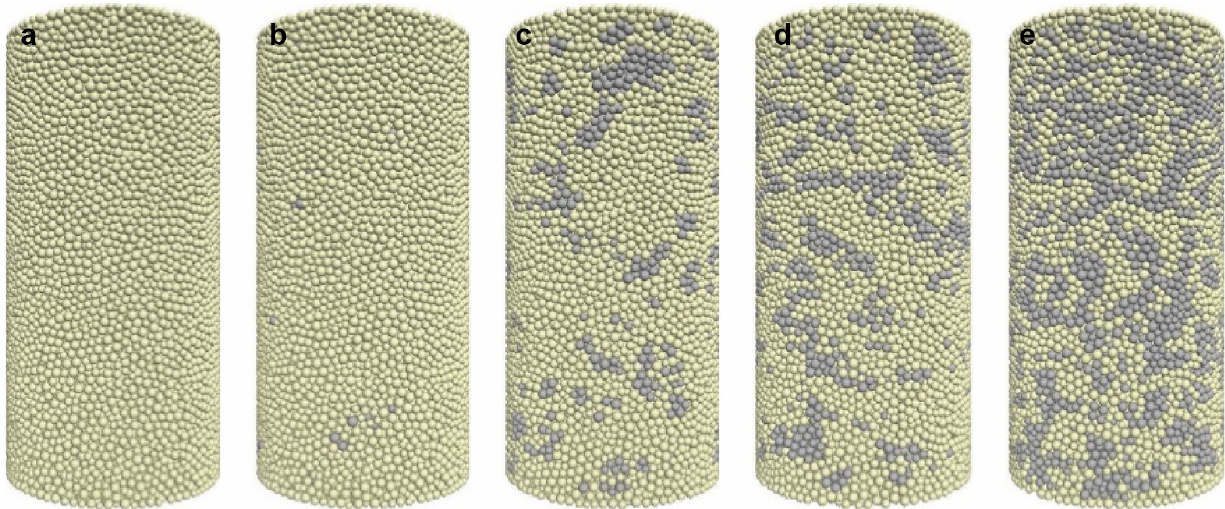
Fig. 12 Initial PFC models (Light yellow and gray represent the soil particles and rock particles, respectively; a – e represent rock ratios of 0%, 10%, 20%, 30% and 50%, respectively)